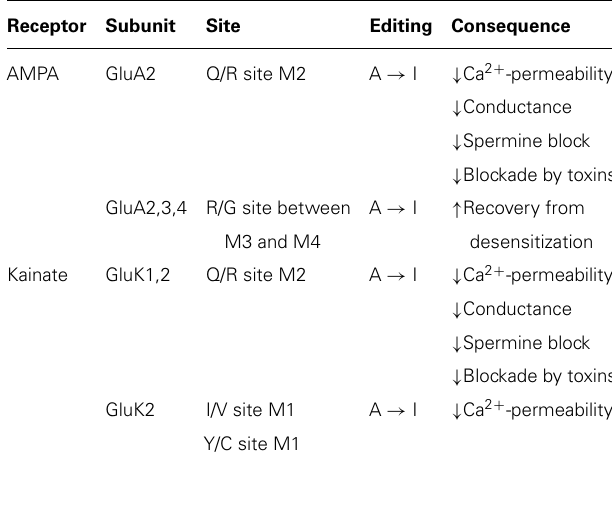
Table 1 | Summary of ionotropic glutamate receptor editing sites and their effects. Receptor Subunit